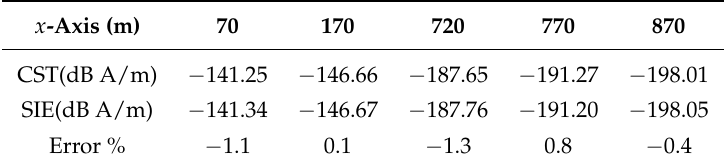
Table 5. Magnetic field in the y -direction component at test point ( x ,0, − 500 ) . x -Axis